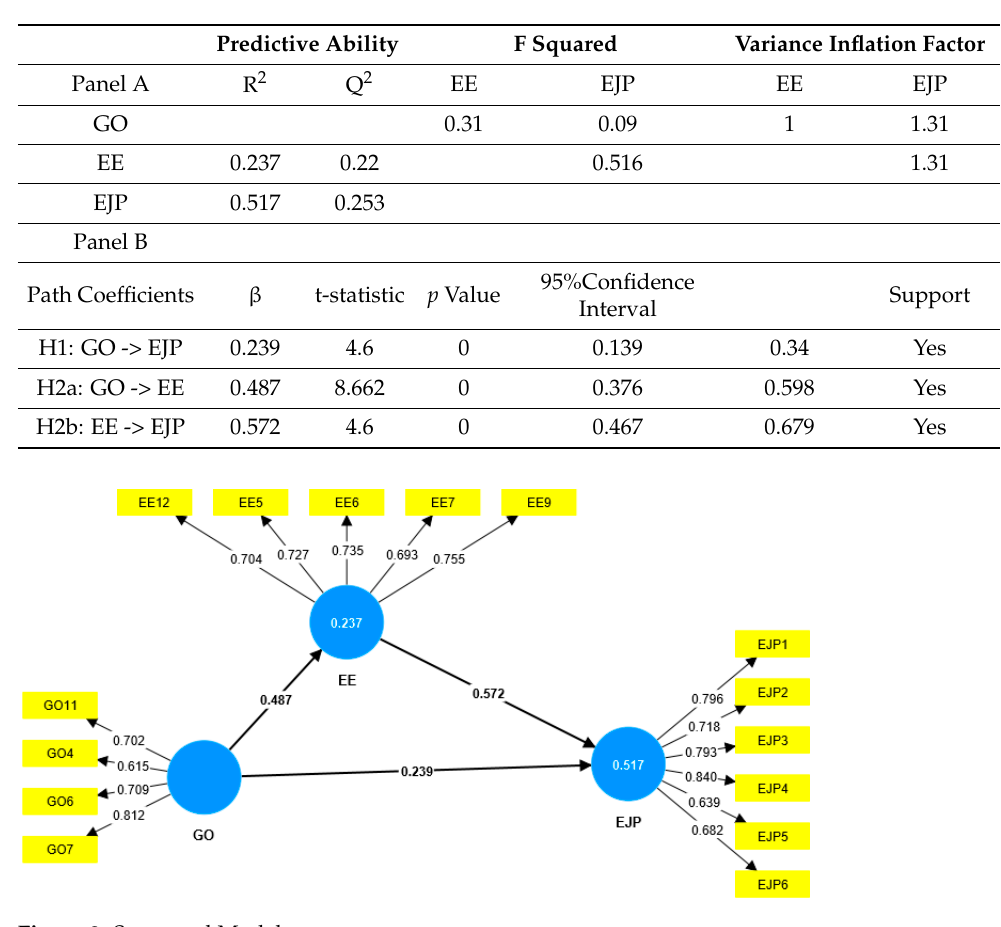
Table 5. Structural Model